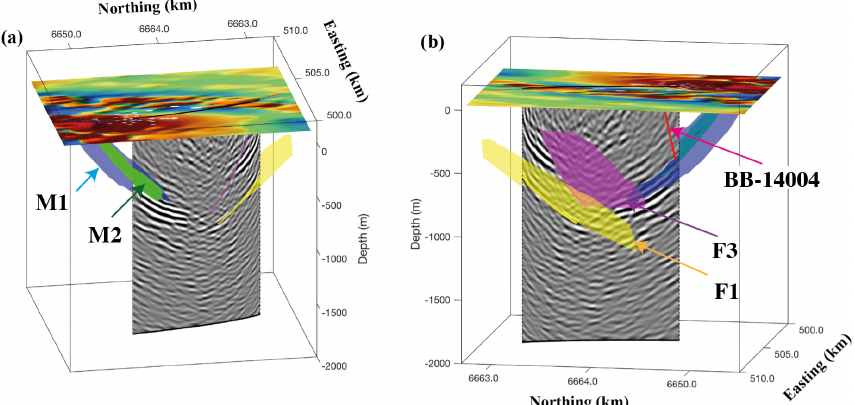
Figure 9. 3D view integrating the RTM section with other geophysical data. (a) M1 and M2 are 3D ore block models intersecting the strong reflectors in the seismic section. These imaged strong reflectors also correlate well with the high magnetic anomaly seen on the northern part of the profile in the overlaid magnetic map. (b) Two inferred fault planes (F1 and F3) as mapped by the recent 3D seismic data in the area and borehole BB14004 (solid red line) intersecting the deposits. A small discrepancy between the imaged reflectors and the inferred fault planes (F1 and F3) might be due to the out-of-plane nature of these features producing a biased dip in the 2D RTM